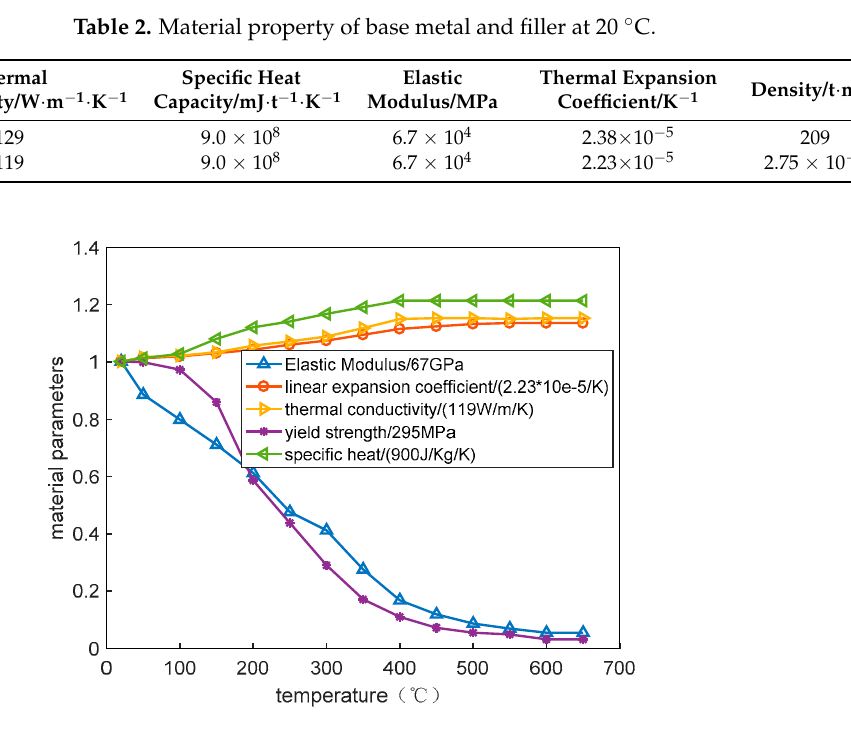
Table 1. Chemical compositions of 7005 and ER5356 wt% .